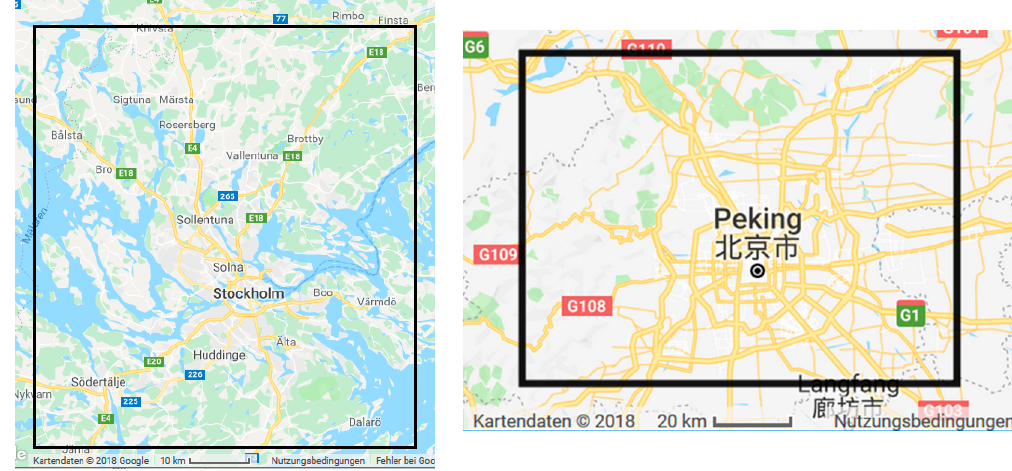
Figure 1. Stockholm (left) and Beijing (right) study site extents.